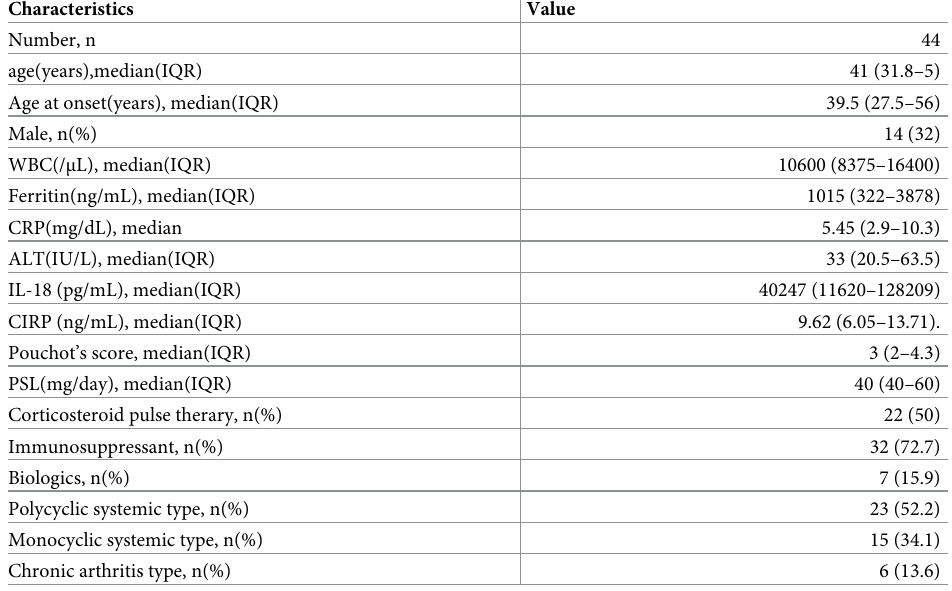
Table 1. Characteristics of AOSD